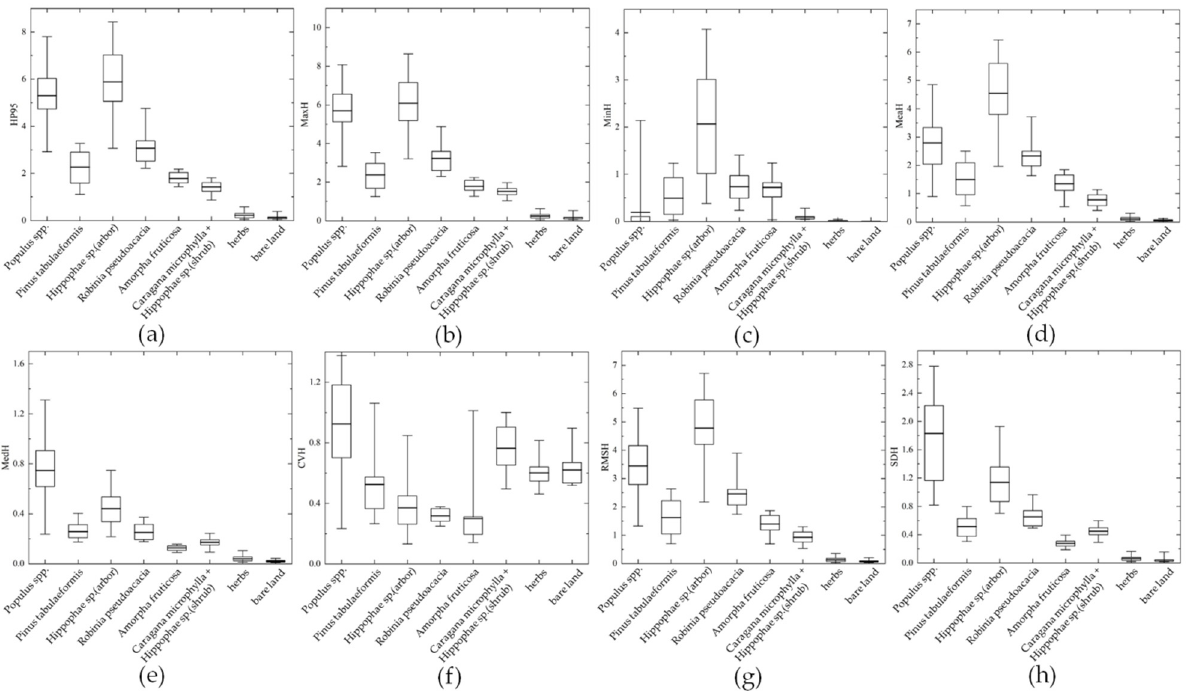
Figure 4. Height distribution (in meters) of eight types of vegetation species composition: ( a ) height percentile of 95% (HP95); ( b ) maximum height (MaxH); ( c ) minimum height (MinH); ( d ) mean height (MeaH); ( e ) median height (MedH); ( f ) coefficient of variation (CVH); ( g ) root mean square of height (RMSH); ( h ) standard deviation of height (SDH). Table 3. The heights of trees, shrubs, herbs, and bare land with maximum, minimum, median, and standard deviation values.